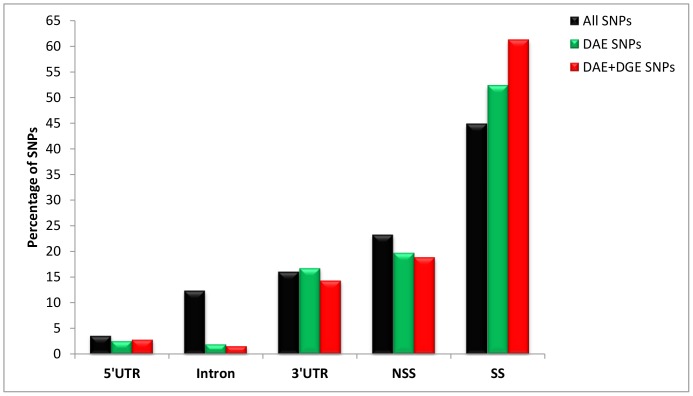
Distribution of SNPs from different regions of the E. nitens transcriptome.All SNPs – All SNPs identified that are common in both Florentine and Meunna; DAE SNPs – SNPs that showed differential allelic expression (Bonferonni P<0.0001) in both trials; DAE+DGE SNPs – SNPs with differential allelic expression present in genes with differential gene expression (FDR<0.05).